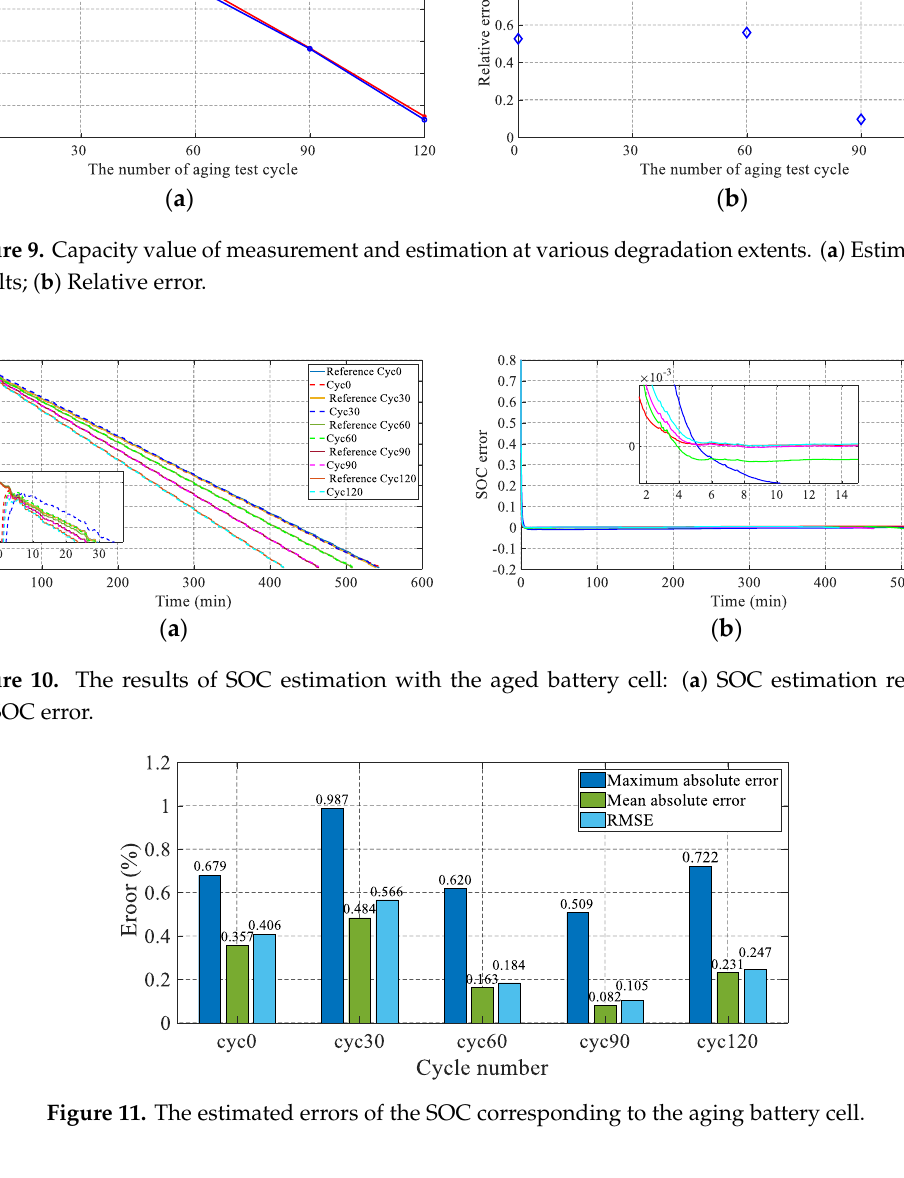
Figure 9. Capacity value of measurement and estimation at various degradation extents. ( a ) Estimation results; ( b ) Relative error.